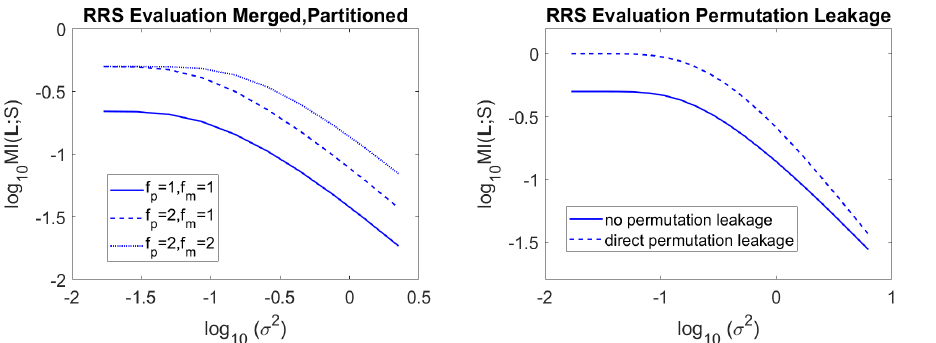
Figure 8: RRS MI